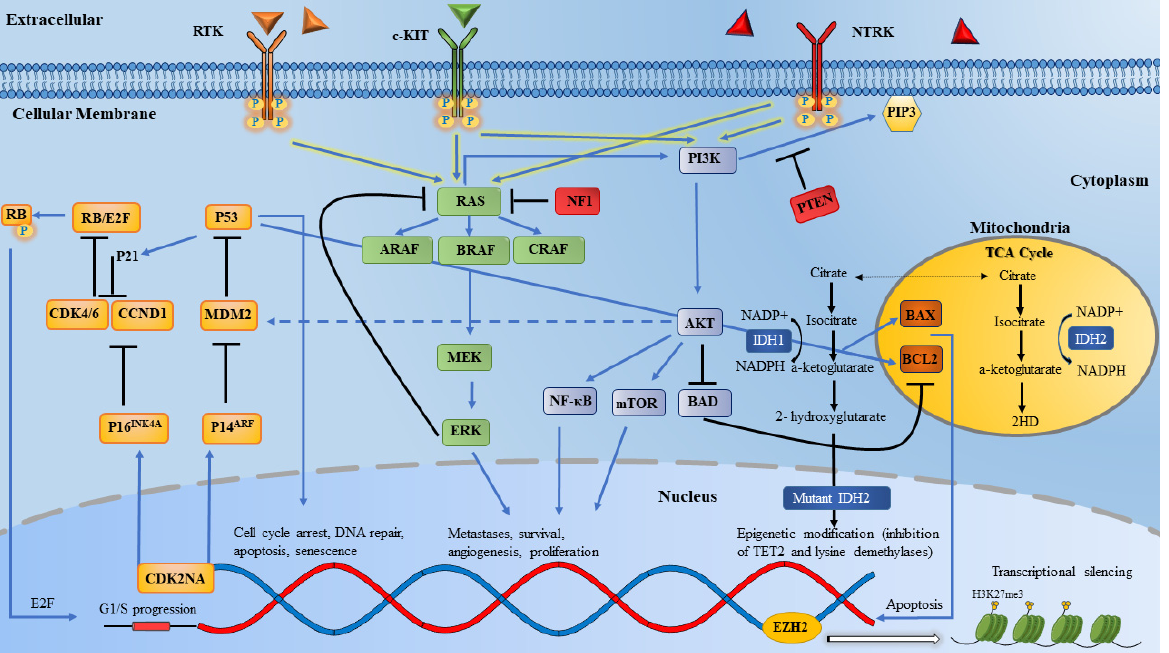
Figure 2. Major signaling pathways in melanomas. The most essential pathways in melanomagenesis are the MAPK pathway (in green) and the PI3K pathway (violet). The MAPK pathway is activated by receptor tyrosine kinase and G-protein-coupled receptors. This activates RAS proteins, which in turn activates MEK , and then ERK. ERK can then translocate to the nucleus and phosphorylate transcriptional factor substrates involved in cell survival. NF1 negatively regulates RAS proteins which inhibits downstream RAS signaling. The PI3K pathway can be activated by RAS or through the inactivation of PTEN . PI3K can activate several pathways ( BAD, NF-kB ) and AKT pathways, which in turn leads to phosphorylation of mTOR, which leads to increased cellular proliferation. The CDKN2A pathway is another essential network in melanomas (yellow). CDKN2A encodes two inhibitory variants of the G1–S phase. These inhibitors (tumor suppressors) are P16 INK4A , which can bind to CDK4/6 , preventing them from interacting with CCND1 and RB phosphorylation. When phosphorylated, RB can release an E2F factor which leads to G1–S cell cycle progression. P14 ARF can bind to MDM2 which is responsible for p53 degradation. Epigenetic regulators can be altered in melanomas. IDH1/2 are enzymes that convert isocitrate